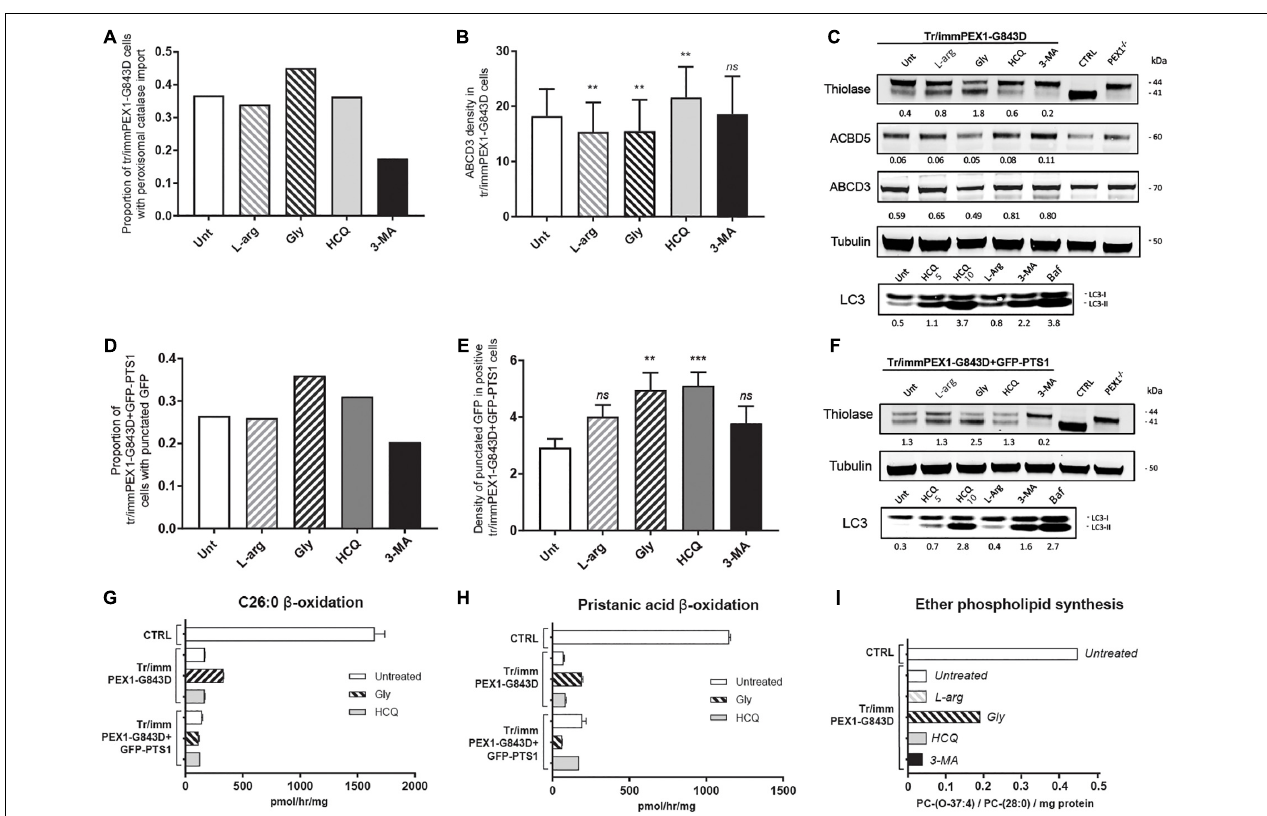
FIGURE 4 | Autophagy inhibitors do not restore import of peroxisomal matrix proteins and metabolic functions in transformed-and-immortalized patient cells. The effect of treatment with different compounds on peroxisomal matrix protein import and peroxisomal metabolic functions was assessed in previously reported PEX1-G843D fibroblasts that had been transformed and immortalized (tr/immPEX1-G843D) (Zhang et al., 2010) as well as in the same cells stably overexpressing GFP-PTS1 (tr/immPEX1-G843D + GFP-PTS1) (Zhang et al., 2010). Cells were treated with 20 mM L-arginine (L-arg), 5% glycerol (Gly), 10 µ M hydroxychloroquine (HCQ), or 10 mM 3-methyladenine (3-MA) for 24 h. (A) Quantification of tr/immPEX1-G843D cells that display functional peroxisomal catalase import after treatment. Cells were analyzed by immunofluorescence microscopy to determine the subcellular localization of catalase ( > 150 cells analyzed for each condition). (B) Density of ABCD3 punctated structures (indicating peroxisomal membranes) per cell area determined in treated tr/immPEX1-G843D cells using immunofluorescence microscopy (see Materials and Methods for more details). Data is presented as mean of n > 45 cells ± SD. (C) Immunoblot analysis of homogenates of tr/immPEX1-G843D cells, which were treated for 7 days with the different compounds. The protein levels and processing of thiolase and the PMPs ACBD5 and ABCD3 were determined using specific antibodies. Below the thiolase bands, the corresponding ratios between the intensity of processed (41 kDa) over unprocessed (44 kDa) thiolase are indicated. Below each ACBD5 and ABCD3 band the corresponding signal intensity relative to the tubulin band intensity, which was used as a loading control, is indicated. Homogenates of control (CTRL) and PEX1-null (PEX1 − / − ) primary fibroblasts were used as controls. To study the effect of different treatments on autophagy we determined the ratio of LC3-II over LC3-I (7 days incubation). For this, we also treated cells with 5 µ M hydroxychloroquine and 10 µ M bafilomycine (24 h). (D) Quantification of tr/immPEX1-G843D + GFP-PTS1 cells that display punctated GFP structures after treatment. Cells were analyzed by fluorescence microscopy to determine the subcellular localization of GFP ( > 120 cells analyzed for each condition). (E) Density of punctated GFP structures per cell area in treated tr/immPEX1-G843D + GFP-PTS1 cells, which display GFP punctated structures (i.e., cells with cytosolic GFP excluded; see Materials and Methods for more details). Data is presented as mean of n > 40 cells ± SEM. (F) Immunoblot analysis of homogenates of tr/immPEX1-G843D + GFP-PTS1 cells, which were incubated for 7 days with the different compounds. See also at C for annotations. (G,H) Peroxisomal β -oxidation activity of C26:0 (G) and pristanic acid (H) in tr/immPEX1-G843D and tr/immPEX1-G843D + GFP-PTS1 cells, which were incubated for 7 days with 5% glycerol (Gly) or 10 µ M hydroxychloroquine (HCQ). Primary fibroblasts derived from a control individual were used as reference. The activity is presented in pmol/hr/mg protein as mean + SD ( n = 3). (I) de novo synthesis of the ether phospholipid PC-(O-37:4) in tr/immPEX1-G843D cells which were treated for 7 days with the different compounds. Primary fibroblasts derived from a control individual were used as reference. Ether phospholipid synthesis is expressed as PC-(O-37:4) over PC-(28:0) over mg protein (mean of two measurements); PC-(28:0) was used as internal standard. Statistical analyses of treated cells versus untreated cells in panels (B,E) were performed using Mann Whitney U tests (** p < 0.01, *** p < 0.001, ns not